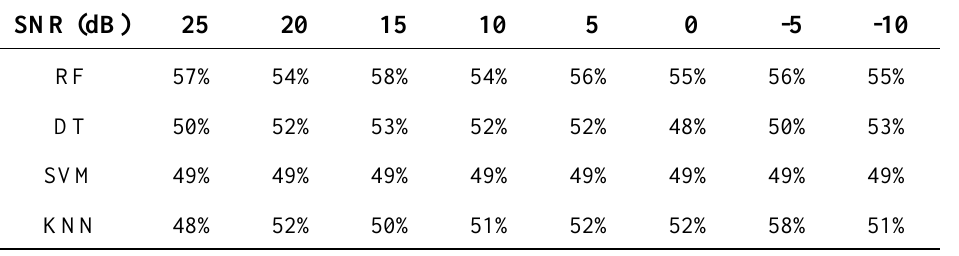
Table 2. The Accuracy of each Classification Method in Its Signal Noise Ratio applying the phase of